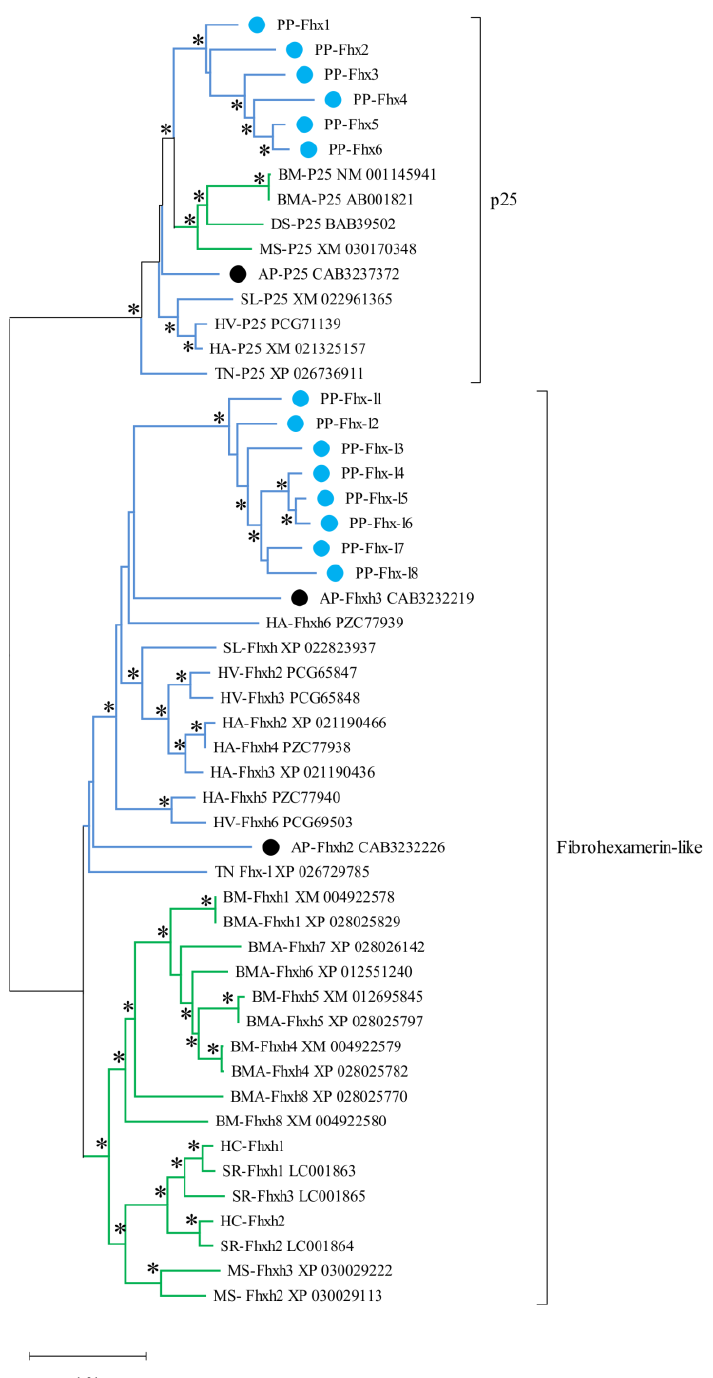
Figure 6. Expansion of fibrohexamerins and fibrohexamerin-like proteins in P. prasinana . The dendrogram also contains sequences from several members of the superfamily Bombycoidea (shown with green lines; B. mori , BM; B. mandarina , BMA; Manduca sexta , MS; Dendrolimus spectabilis , DS; Samia ricini , SR; Hyalophora cecropia , HC) and Noctuoidea (shown with blue lines; S. litura , SL; Heliothis virescens , HV; Helicoverpa armigera , HA; T. ni , TN). Pseudoips prasinana (PP) sequences are highlighted by blue dots whilst sequences from its closest studied relative, A. plantaginis (AP), are highlighted by black dots. The maximum-likelihood method was used to reconstruct the phylogeny. Branches with statistical support (Bayes values) higher than 70 are marked with asterisks. We found only two sericins, Src1A and Src1B, in the P . prasinana cocoon by proteomic